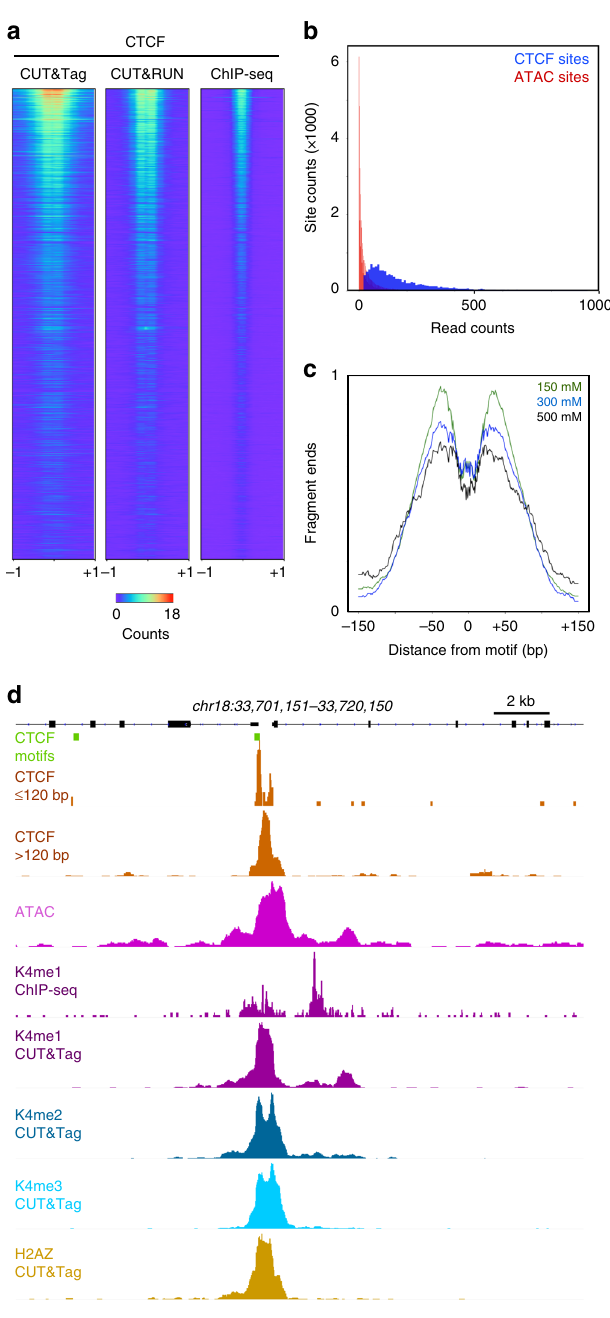
Fig. 5 CUT&Tag pro fi ling of the CTCF DNA-binding protein. a Comparison of methods for CTCF mapping. CTCF motifs in the genome were ranked by e -value, datasets from each method were downsampled to the same read depth, and then read counts were plotted on the fi xed order of sites. b Distribution of read counts in CTCF CUT&Tag pro fi ling. Sites were called from CUT&RUN pro fi ling (blue) and at non-overlapping accessible sites (red, called from ATAC-seq). Read counts from CTCF CUT&Tag were plotted for each category. c Resolution of CUT&Tag. Mean plots of fragment end positions from CTCF CUT&Tag centered over CTCF motifs in called peaks. Three different NaCl concentrations were used in wash buffers during and after pA-Tn5 tethering. Data are represented as a fraction of the maximum signal within the interval. d Resolved structure of a CTCF binding site. The promoter of the SLC39A6 gene on chromosome 18 shows the chromatin features around a CTCF-bound site. Source data are available in the Source Data fi